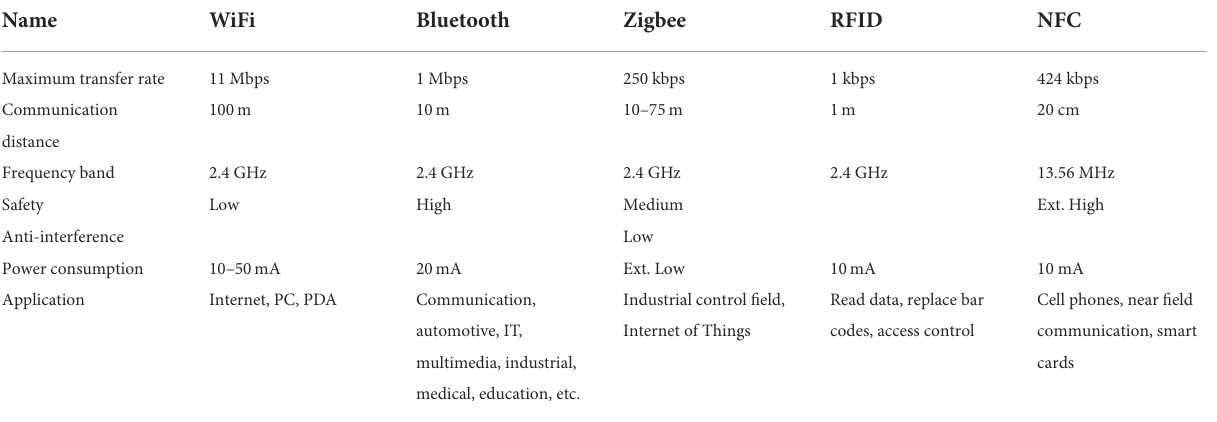
TABLE 1 Comparison of parameters of different wireless communication technologies